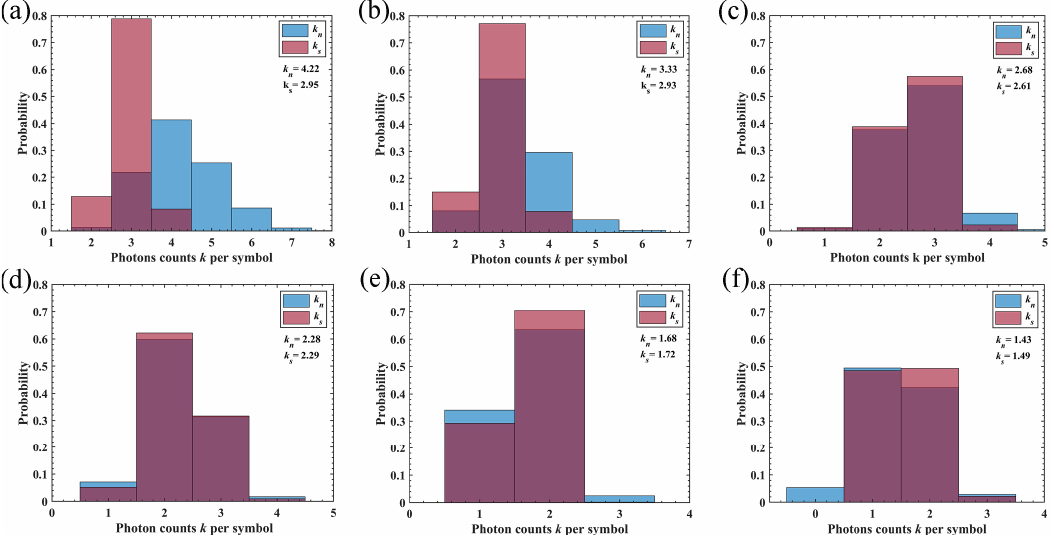
Figure 13. The frequency histogram of photocounts per symbol times for 32-PPM photon-counting communication system vs. received optical power: ( a ) − 86 dBm, ( b ) − 84 dBm, ( c ) − 82 dBm, ( d ) − 80 dBm, ( e ) − 78 dBm, ( f ) − 76 dBm.